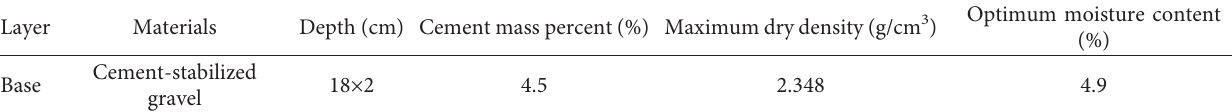
Table 2: Details of the base layer.